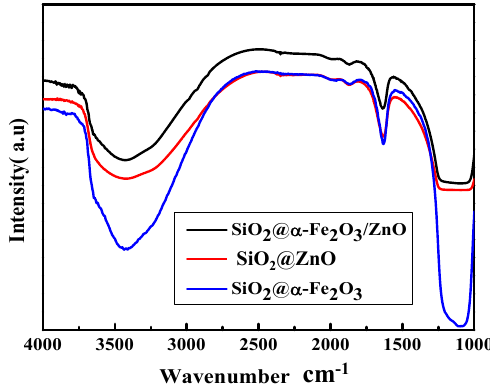
Figure 3. FTIR spectra of SiO 2 @ZnO, SiO 2 @α-Fe 2 O 3 and SiO 2 @α-Fe 2 O 3 /ZnO nanocomposites.